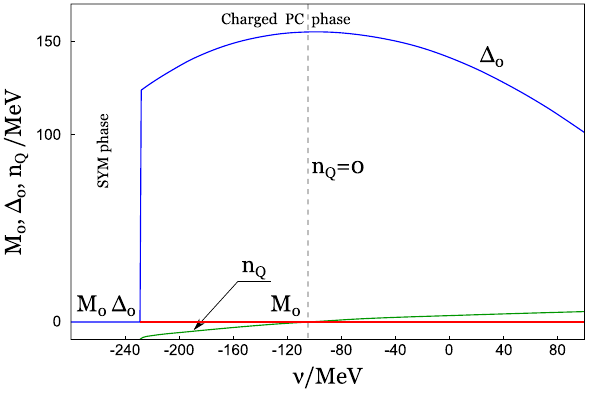
Fig. 11 The condensates (cid:4) 0 , M 0 and electric charge density n Q as a function of ν in the ground state of β -equilibrium quark matter at μ = μ = ν = 400 MeV at the physical point, m 5 5 ν < ν ≈ − 225 MeV the condensates (coordinates of the GMP of the c TDP (29)) correspond to the ApprSYM phase, at ν > ν c the charged PC phase of β -equilibrium quark matter is realized. Note that at the point ν = ν 0 ≈ − 105 MeV we have n Q = 0. It means that in this case, since ν 0 > ν c , β -equilibrium quark matter is electrically neutral and there the charged PC phase is realized